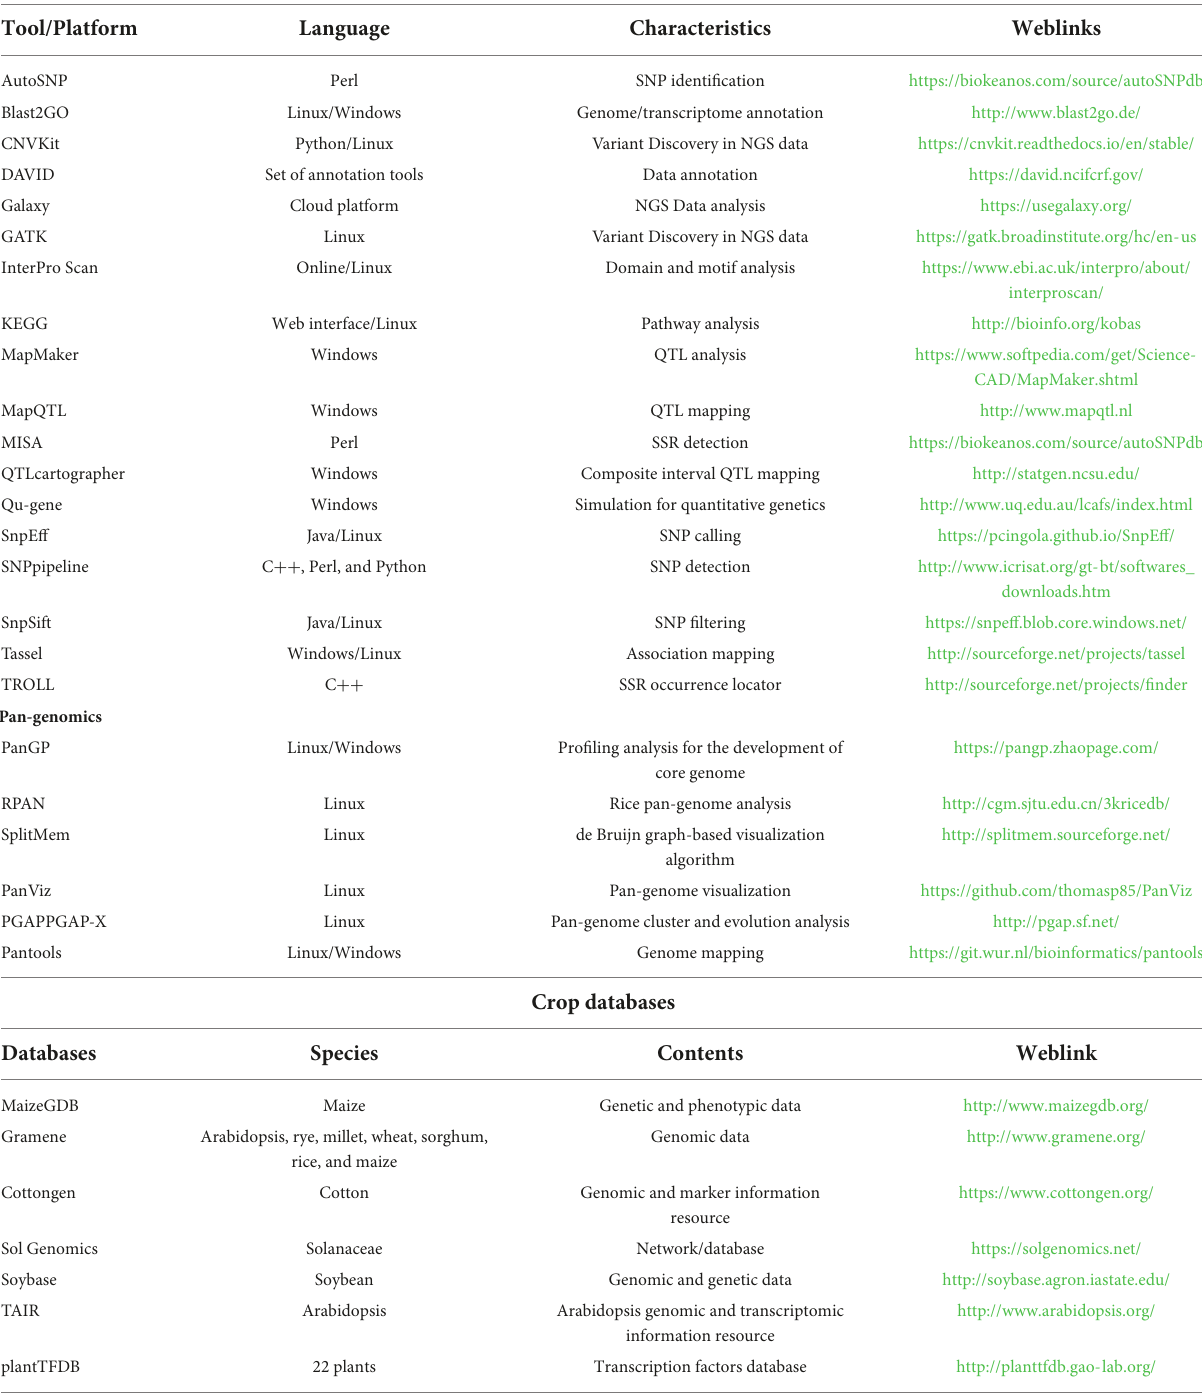
TABLE 1 Bioinformatics tools utilized in modern crop breeding. Tools and platforms used in NGS analysis for crop